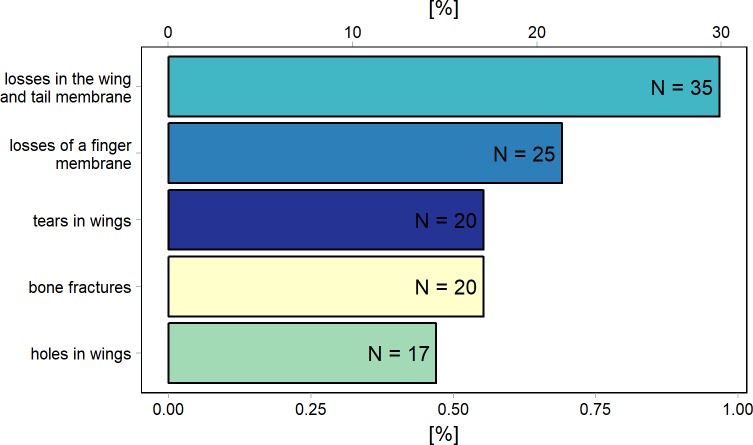
Proportion of damage types in all the bats studied.The upper axis shows the percentage of bats from each wing damage categories among all wing damages (N = 117). The lower axis shows the percentage of bats from each wing damage categories among all observed individuals (N = 3,525).